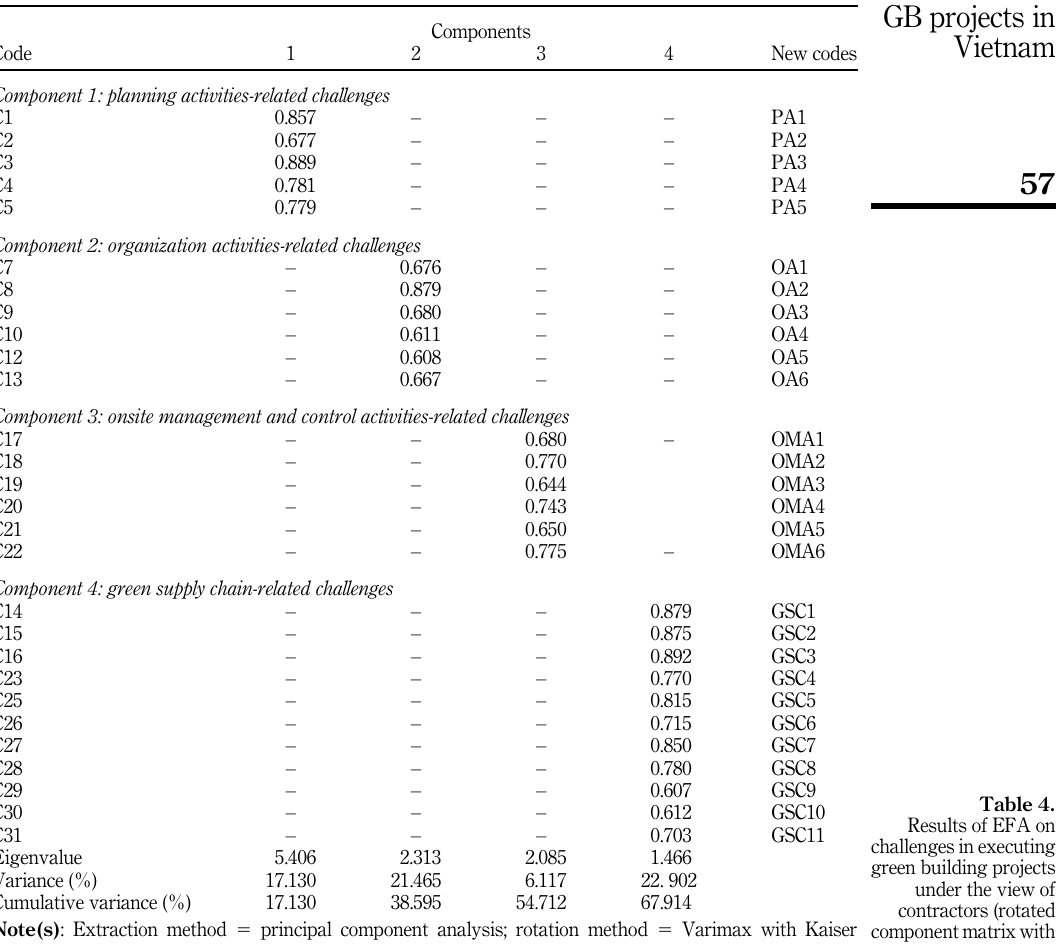
Table 4. Results of EFA